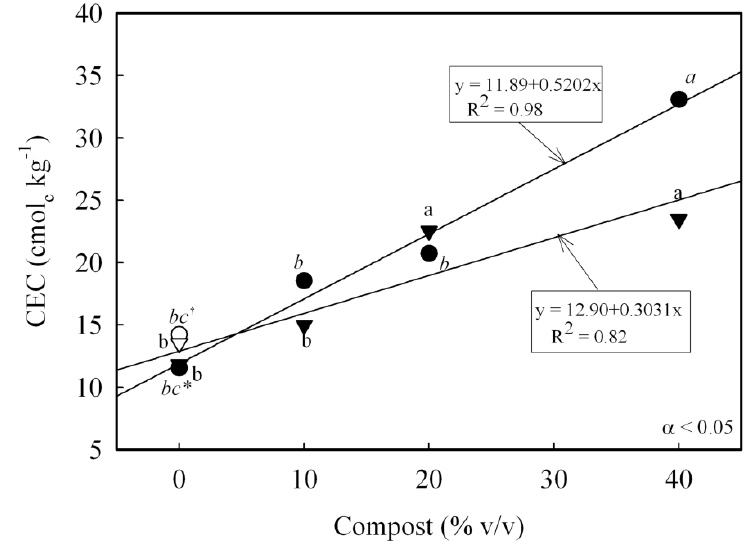
Figure 6. Effect of incorporating composted poultry litter into top 12.7 cm of subsoil on cation exchange capacity (CEC) for ● sodded compost; ○ sodded fertilizer; ▼ seeded compost; and seeded fertilizer plots; * Means with same letters are statistically insignificant based on Fisher’s Protected LSD test ( P ≤ 0.05) (italicized statistics correspond to sodded treatments); † values for standard error were small ranging between 0.065 (min.) to 0.443 (max.) and hence are not shown in